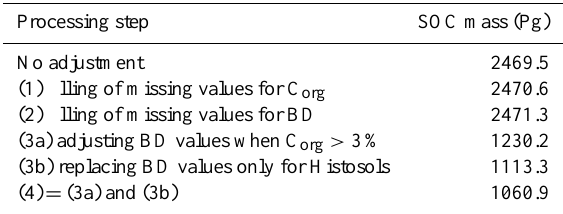
Table 2. Changes to the global SOC mass in the top 1m after each adjustment to the HWSD v.1.1